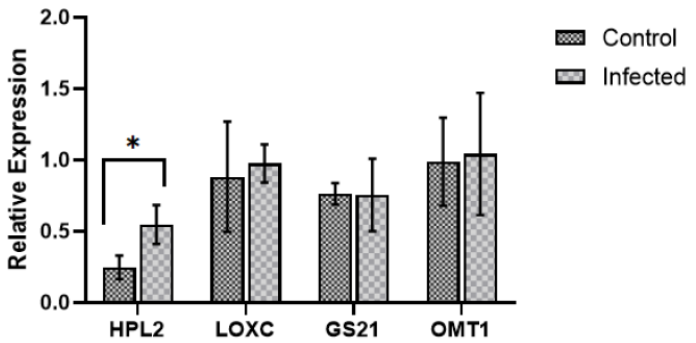
Figure 6. Expression of genes coding for hydroperoxide lyase (HPL)2, lipoxygenase (LOX)C, gly- cosidase (GS)21, and O -methyltransferase (OMT)1 in V. vinifera cv. Trincadeira grapes at the harvest stage EL38 (mock/control and B. cinerea infected). Four controls and four infected samples were analysed by qPCR. Barplot represent the relative expression means, and error bars are standard deviation. Data were analysed with the non-parametric Wilcoxon–Mann–Whitney test. Asterisks indicate significant differences in gene expression between control and infected samples within each method: * p value <